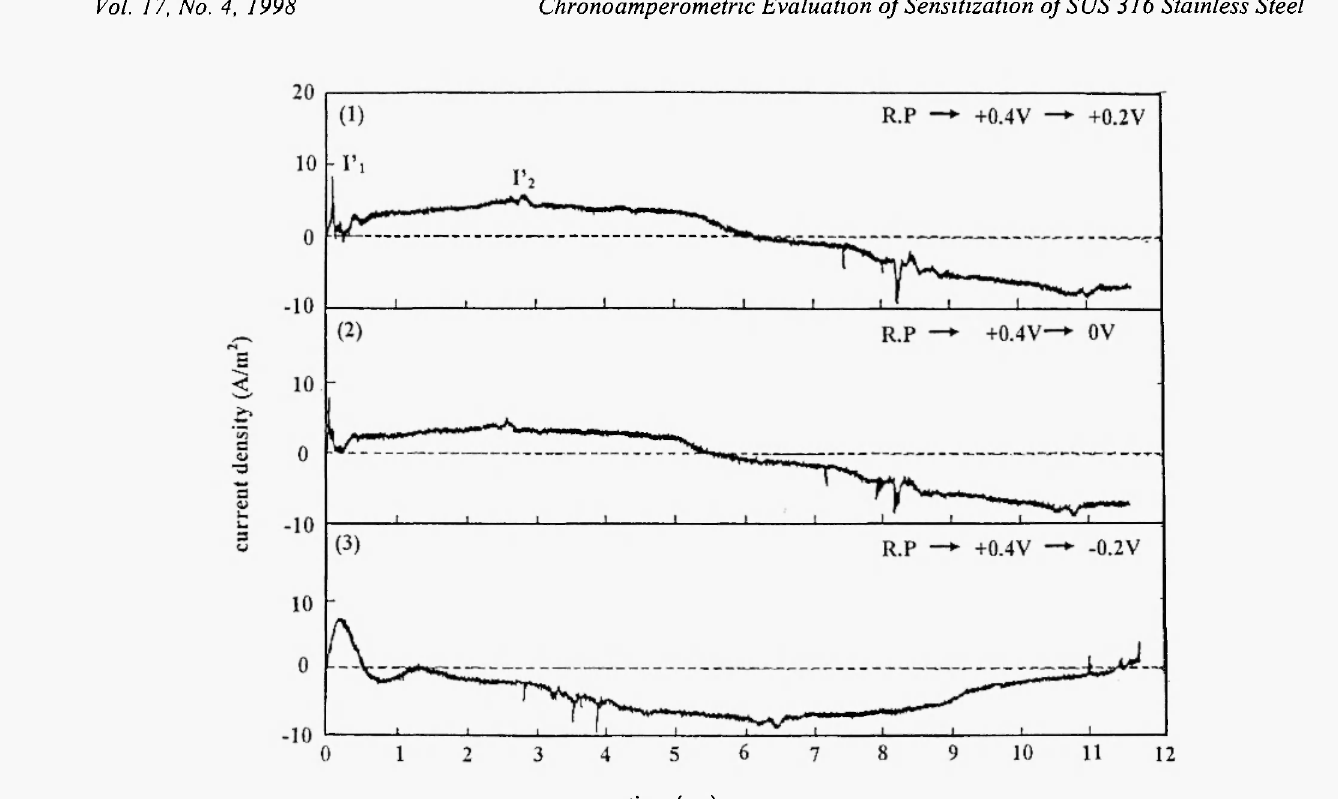
Fig. 8: Chronoamperograms of solution treated SUS316 steel by potential step from +0.4V to less noble potentials.